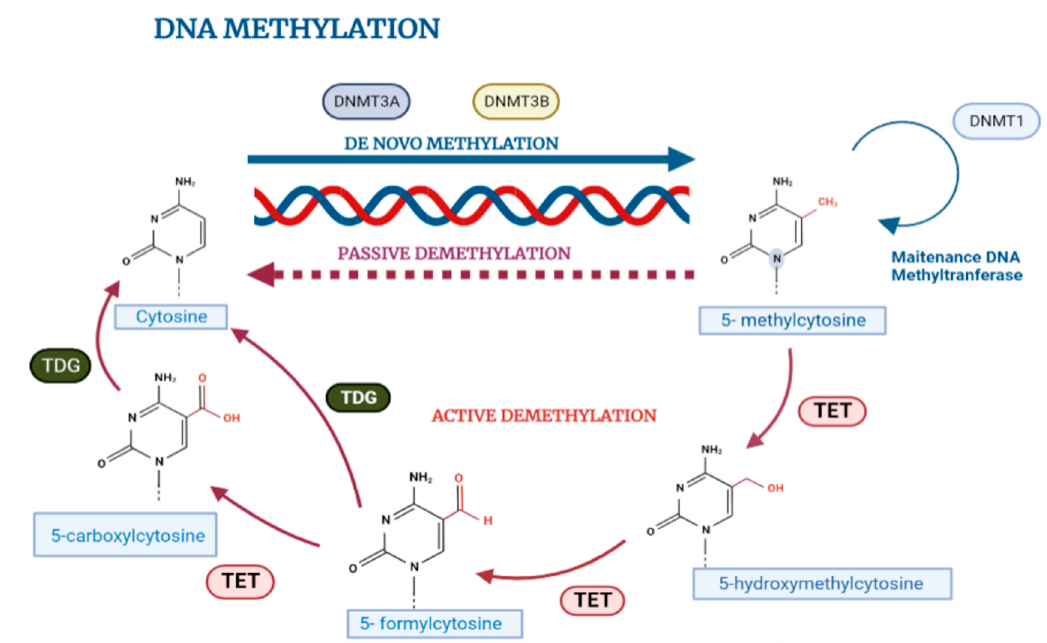
Figure 3. Maintenance and erasure of DNA methylation marks in normal cells. DNA methylation patterns are transmitted during DNA replication, where DNMT1 maintains global DNA methylation, whereas de novo methylation is performed by DNMT3A and DNMT3B proteins in complex with DNMT3L (not shown), a closely related homolog lacking a catalytic domain. DNA methylation marks can be deleted through a molecular mechanism in the absence of functional DNA methylation maintenance machinery during successive rounds of replication. On the contrary, the active demethylation of DNA occurs through an enzymatic process that eliminates or modifies the methyl group of 5 mC by the action of enzymes referred to as ten-eleven translocation (TET) enzymes.